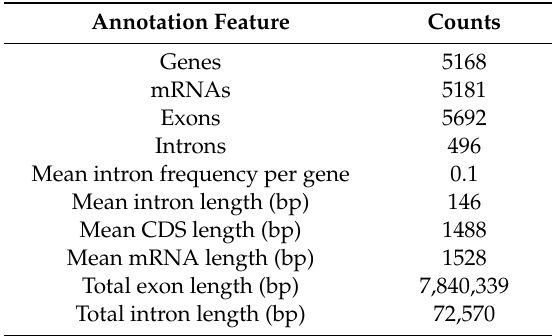
Table 2. Annotation details of the B. naardenensis CBS 7540 genome.